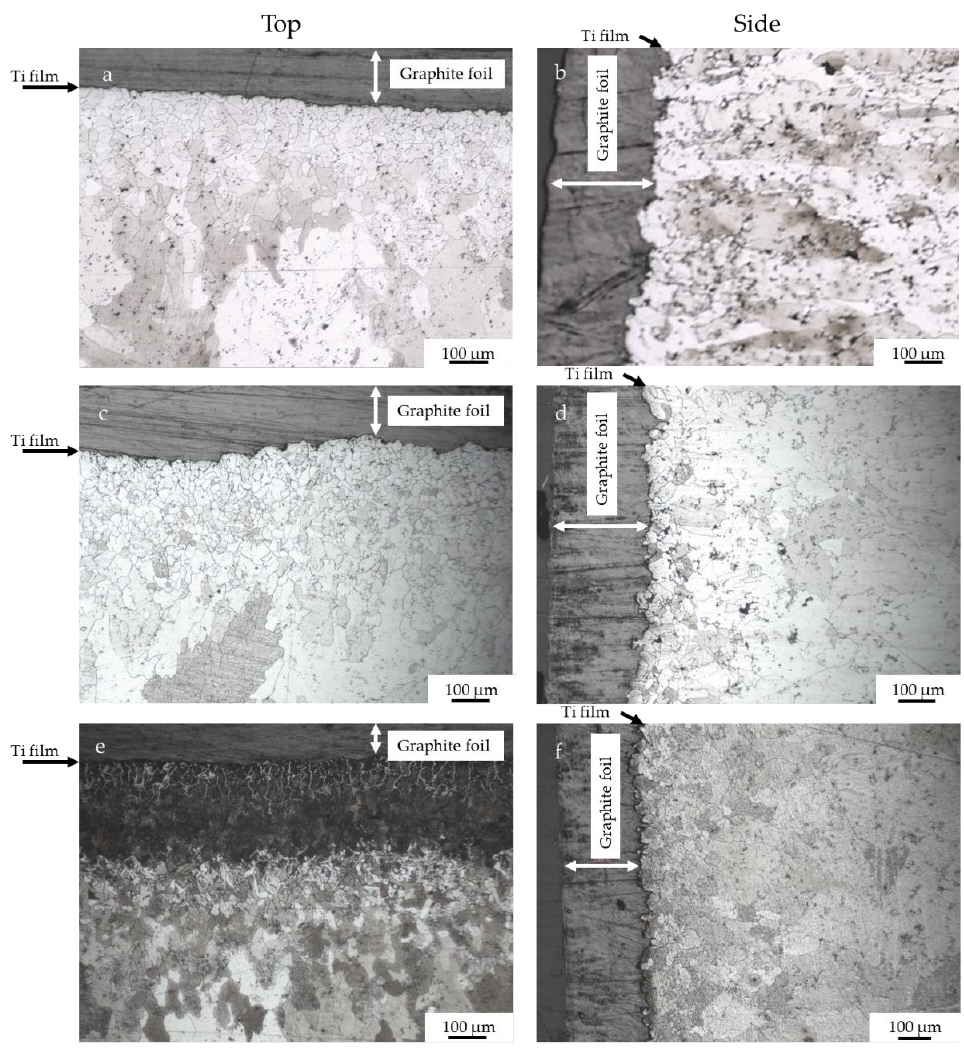
Figure 8. OM observations of the iron samples sintered using graphite foils with Ti coatings of ( a , b ) 1.5 µm thickness, ( c , d ) 1.1 µm thickness and ( e , f ) 0.5 µm thickness.